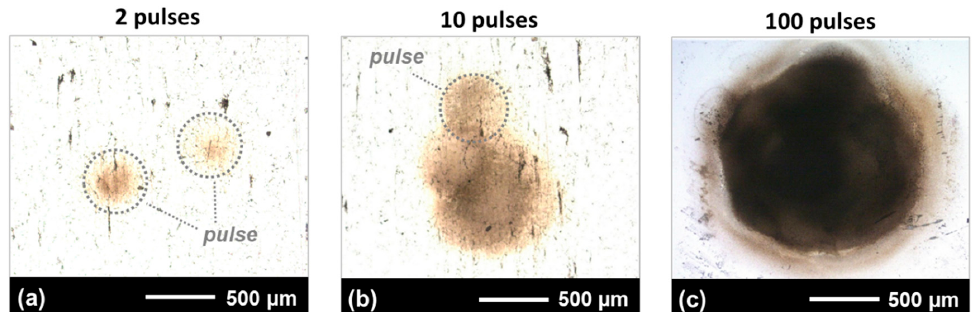
Figure 2. Optical microscopy images showing the femtosecond-filament beam-pointing stability on the substrate surface when the substrate was 55 m from the laser source (approximately 5-meter filament distance), as a function of number of pulses. The number of irradiated laser-filament pulses in this case varied between 1 and 100 ( a – c ).